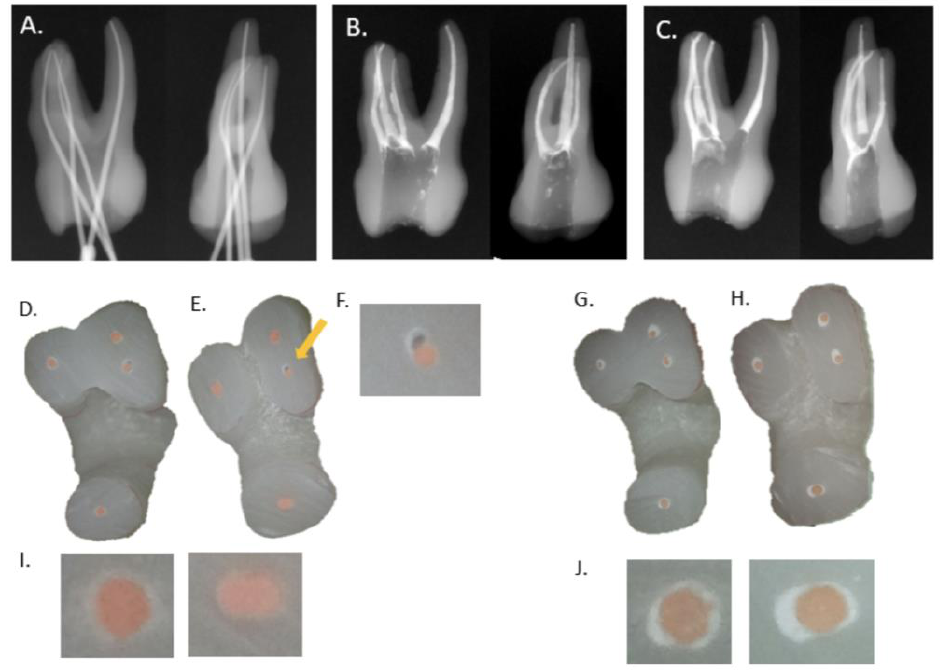
Figure 1. Radiographic and microscopic images of representative specimens. ( A ) Master cone fitting; MB (mesiobuccal canal), TruNatomy Prime; MB2 (the second mesiobuccal canal), Trunatomy Small; DB (distobuccal canal), TruNatomy Prime; P canal (palatal canal), TruNatomy Medium. ( B , C ) Periapical X-ray of a sample in SC (single cone filling) ( B ) and CW (continuous wave filling) ( C ) groups. ( D , E ) Microscopic image of canal filling at 3 mm ( D ) and 6 mm ( E ) from the apical tip of CW group. The yellow arrow indicates the void of the canal filling. ( F ) Magnified image of the void of the canal filling at 6 mm from the apical tip ( G , H ) Microscopic image of canal filling at 3 mm ( G ) and 6 mm ( H ) from the apical tip of SC group ( I ) Microscopic image of CW group of P canal (left, 3 mm; right, 6 mm). ( J ) Microscopic image of SC group of P canal (left, 3 mm; right, 6 mm).